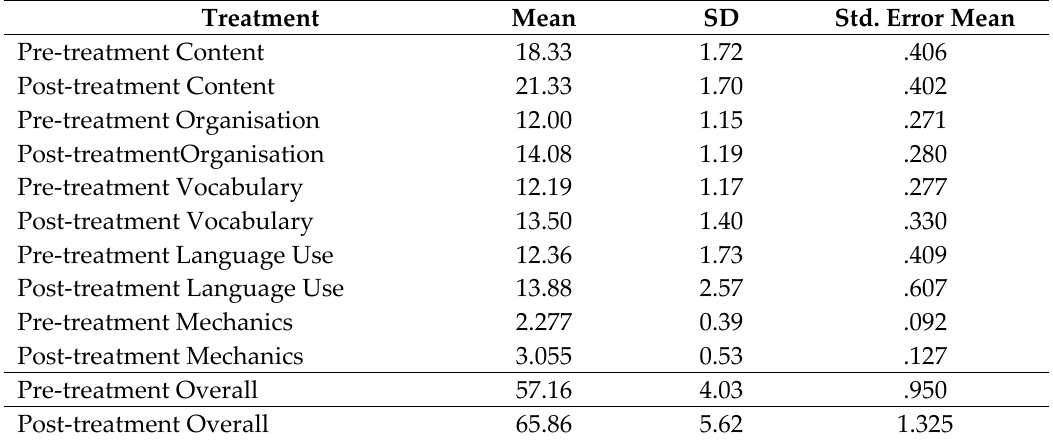
Table 2. Descriptive statistics of the pre-and post-treatment writing scores (n=